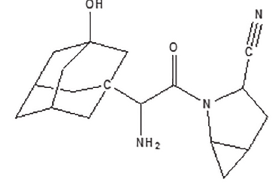
FIGURE 1 - Chemical structure of saxagliptin.